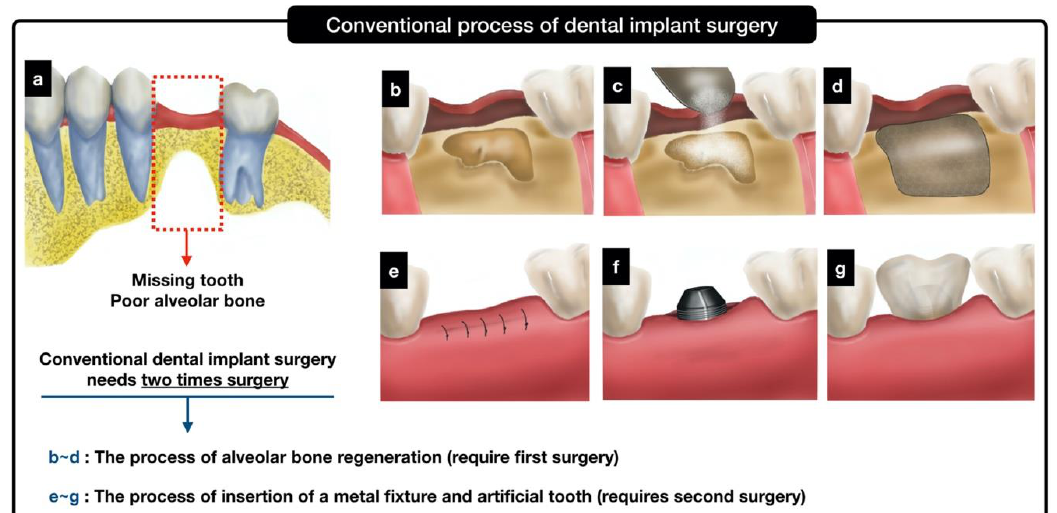
Figure 1. Schematics of a conventional dental implant process and a conceptual process using the proposed hybrid scaffold.